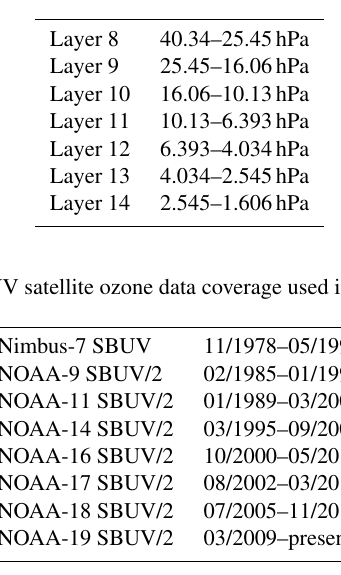
Table 1. Pressure layers in which ozone data have been analysed in this study.